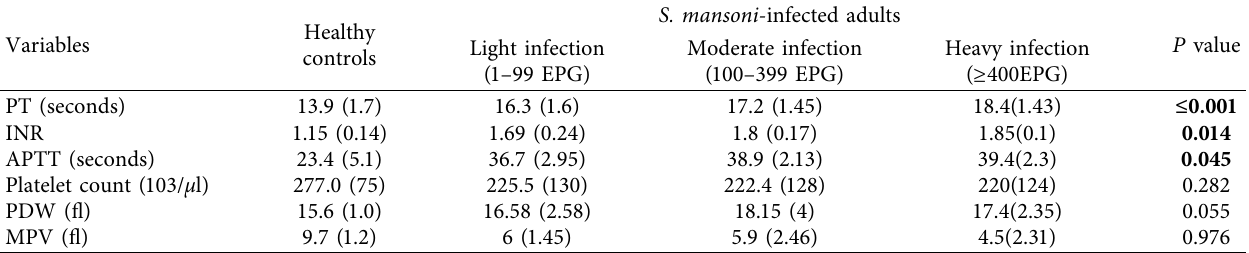
Table 4: Comparison of coagulation profiles and platelet parameters between the intensity of S. mansoni -infected individuals and noninfected individuals (Kruskal–Wallis